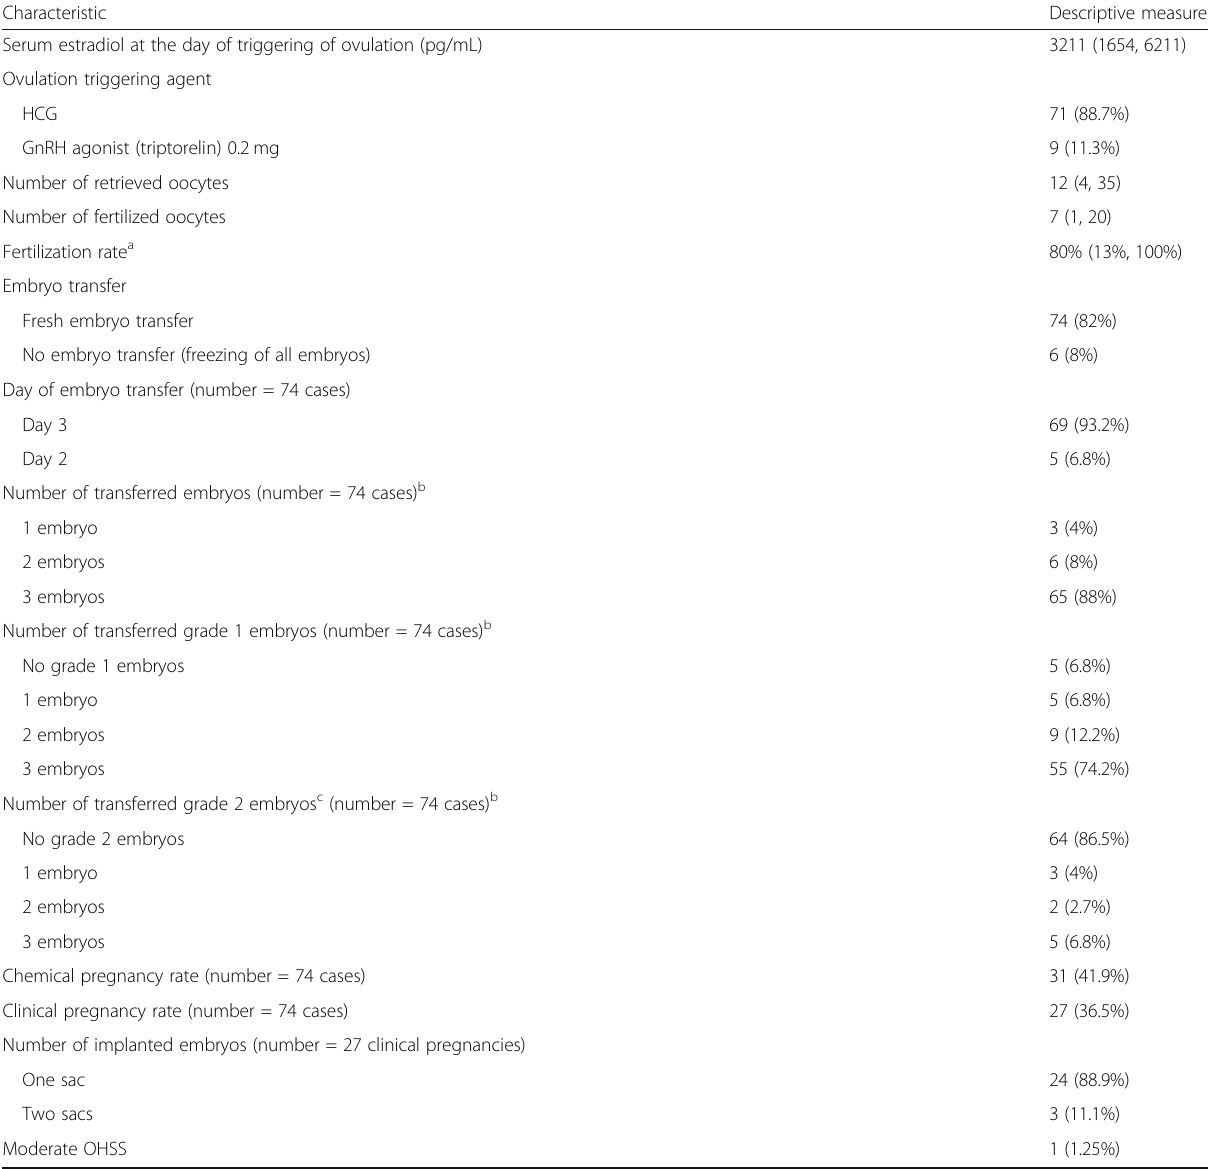
Table 2 ICSI cycle characteristics for the study